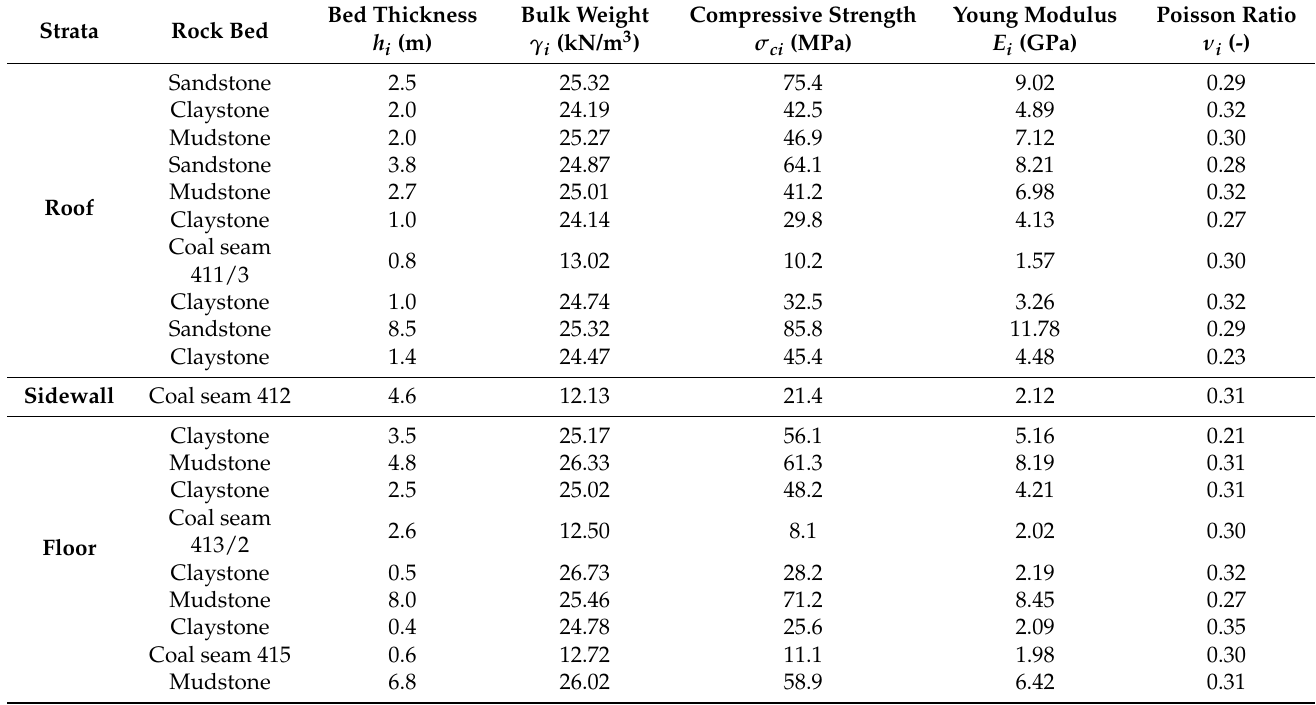
Table 1. Geomechanical parameters of rocks around roadway